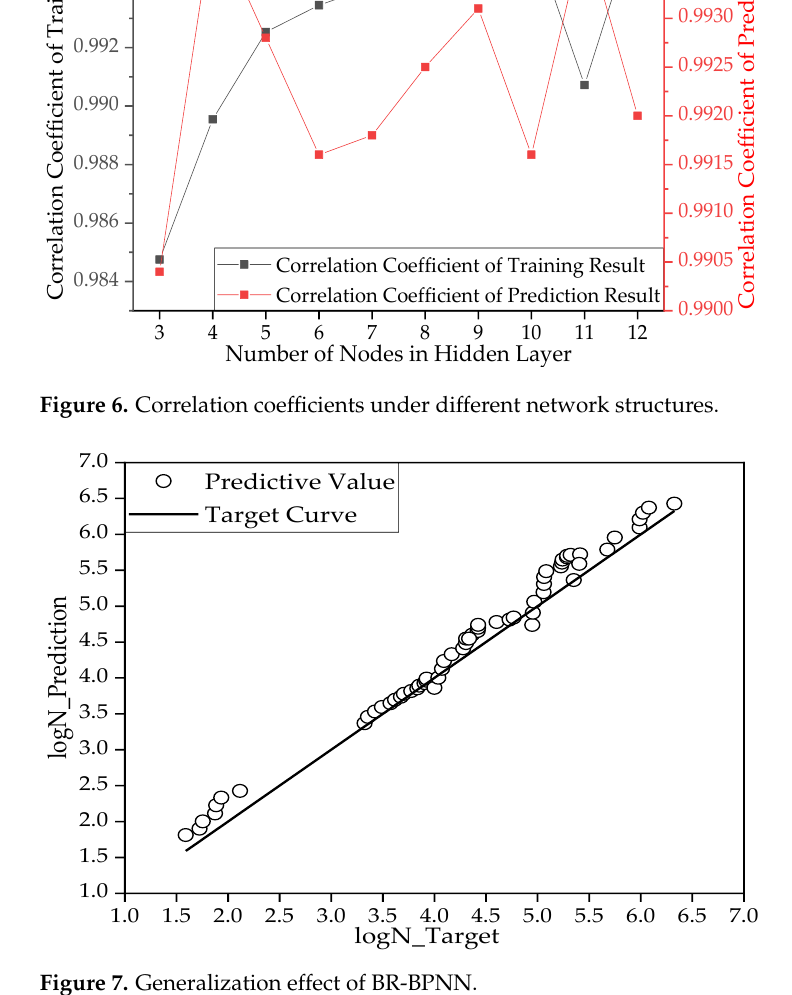
Figure 7. Generalization effect of BR-BPNN.